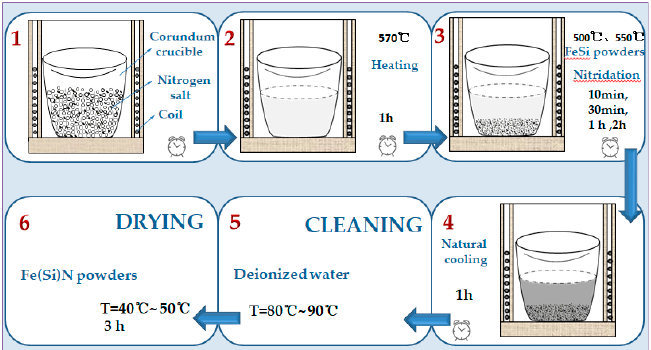
Figure 2. Scheme of the FeSiN powder preparation process.